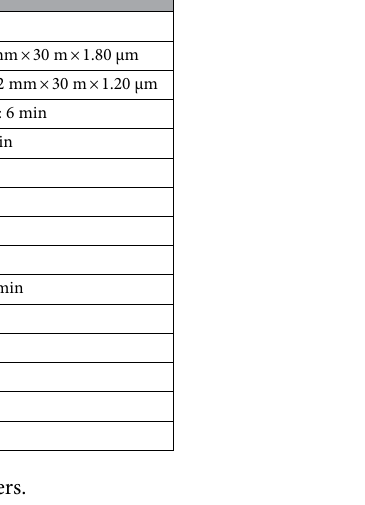
Table 1. Dual column HS-GC-FID/FID operating